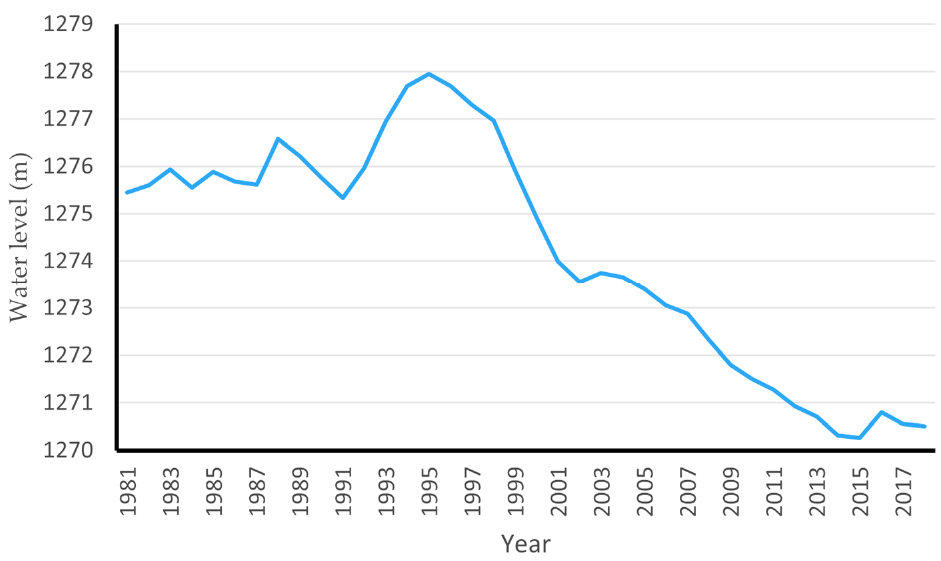
Figure 1. Measured water level (m) of Urmia Lake since 1981.